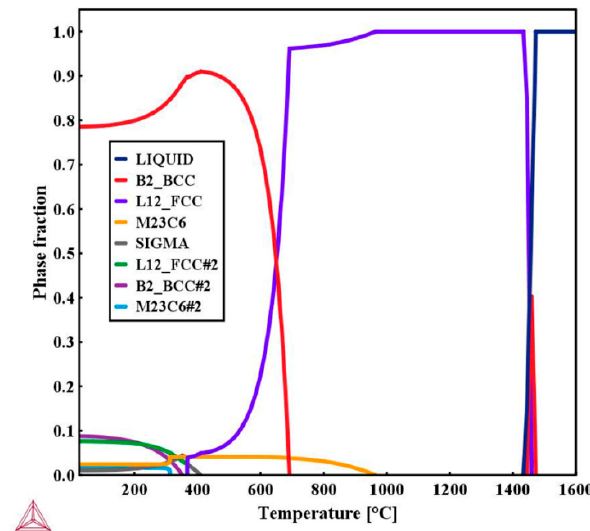
Figure 13 . C alculation of the equilibrium phase diagram of weld metal . Figure 13. Calculation of the equilibrium phase diagram of weld